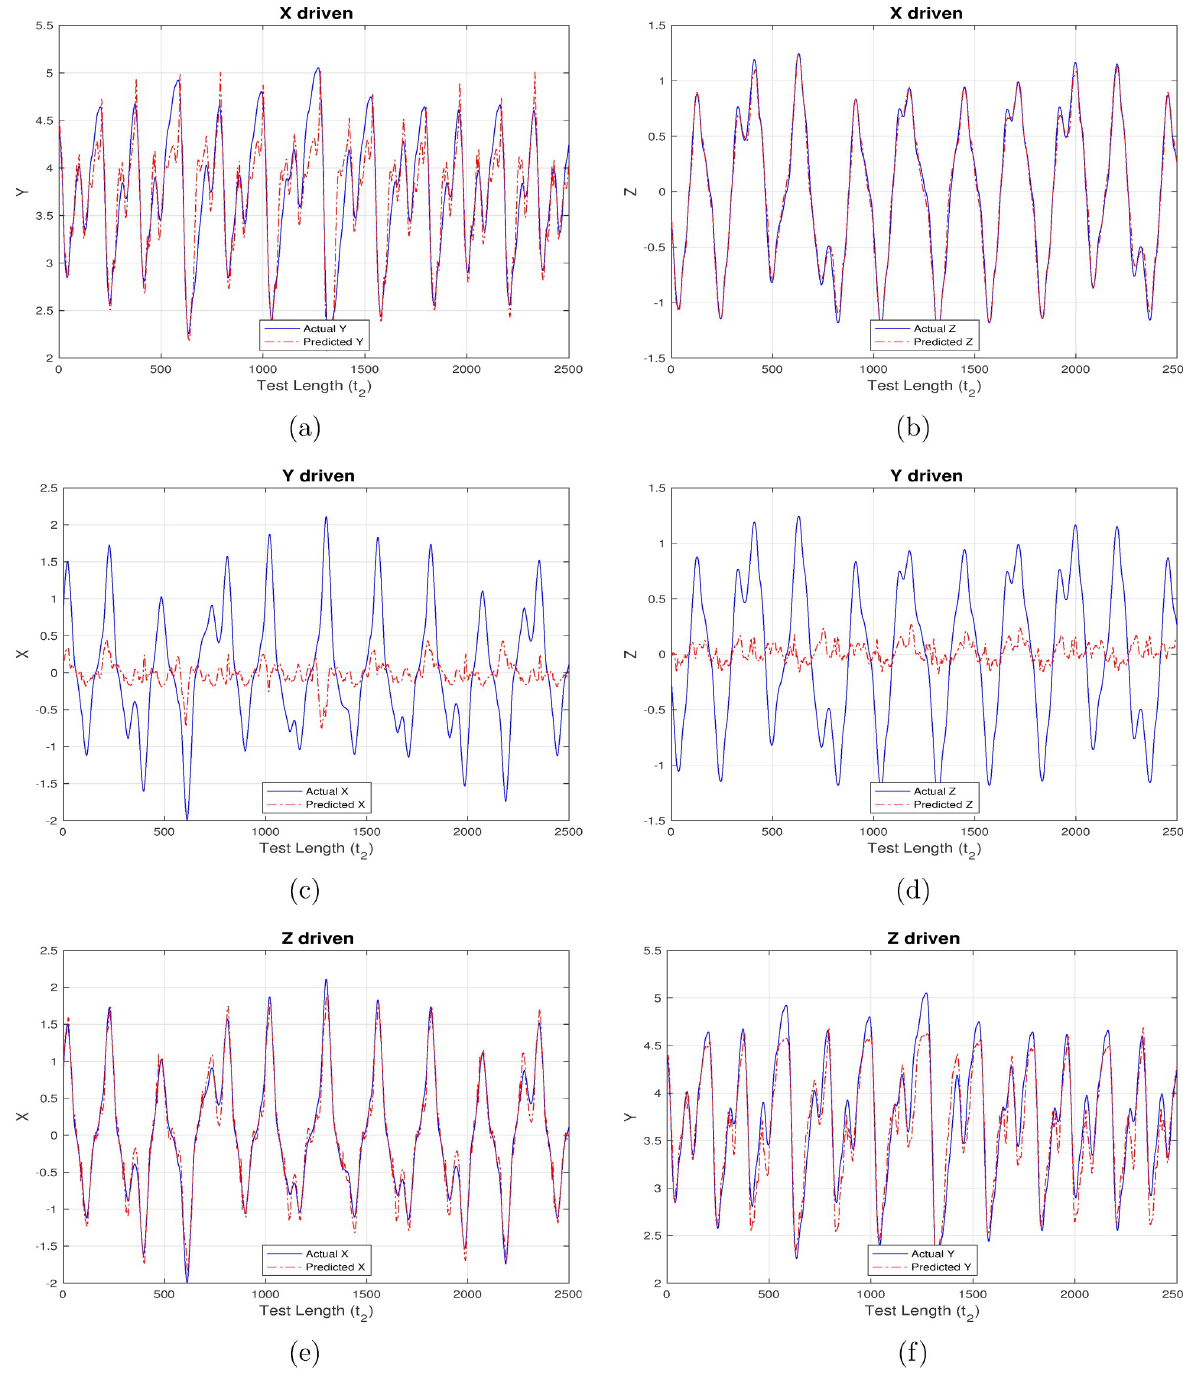
Fig 5. Chaotic financial system component re-generation with “non-Linear” activation. (a) Re-generating “investment demand” [Y] behavior with “interest rate” [X] as input (b) Re-generating “price index” [Z] behavior with “interest rate” [X] as input (c) Re-generating “interest rate”[X] behavior with “investment demand”[Y] as input (d) Re-generating “price index” [Z] behavior with “investment demand” [Y] as input (e) Re- generating “interest rate” [X] behavior with “price index” [Z] as input (f) Re-generating “investment demand” [Y] behavior with “price index” [Z] as